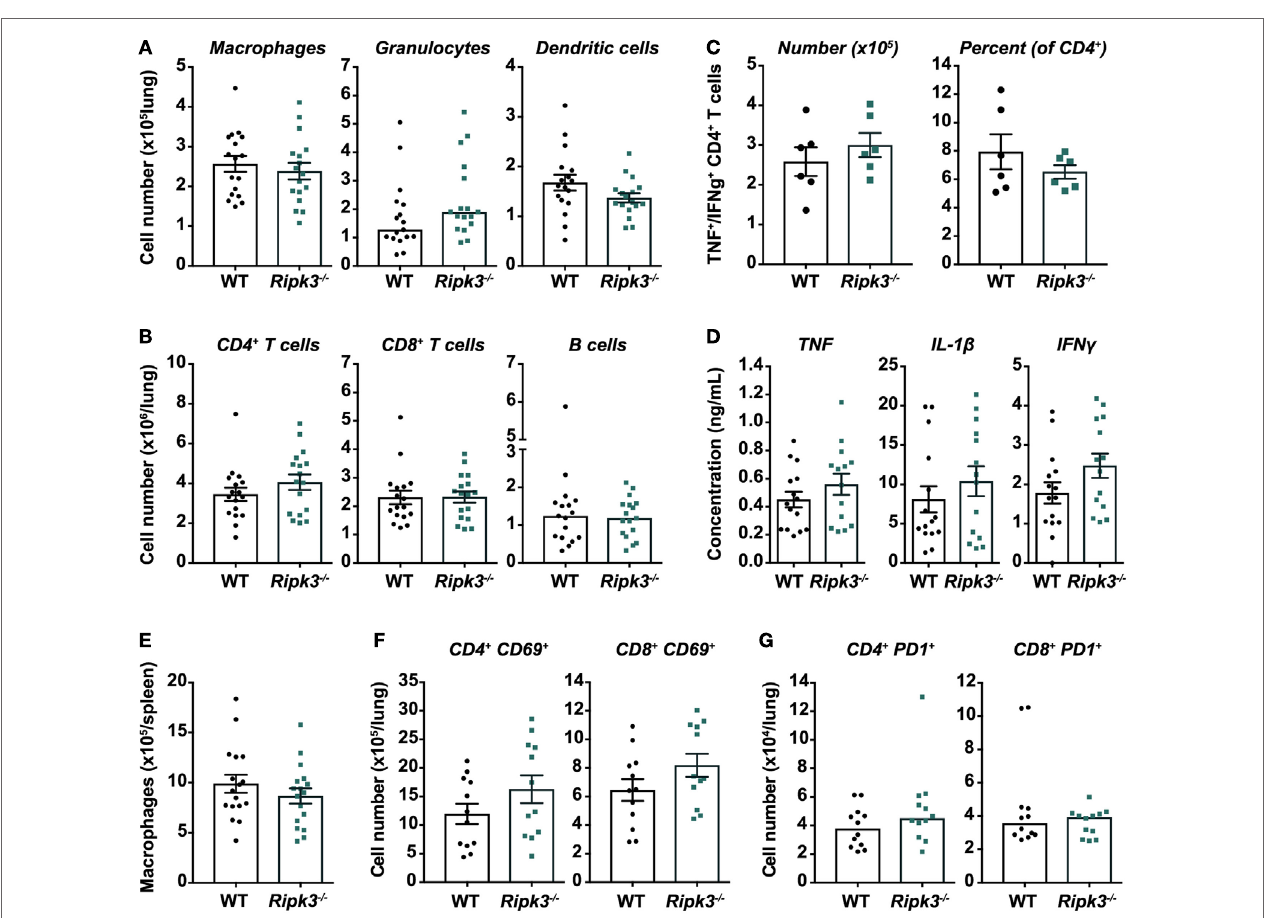
FigUre 4 | Immune responses in Mycobacterium tuberculosis (Mtb)-infected mice are unaltered by receptor-interacting protein kinase 3 deficiency. Total number of (a) myeloid and (B) lymphoid immune cells in the lungs of mice infected with aerosolized Mtb. Flow cytometry was used to identify macrophages/ monocytes (CD11b + Gr1 low ), granulocytes (CD11b + Gr1 high ), dendritic cells (CD11c + MHCII + ), CD4 + and CD8 + T cells, and B cells (CD19 + MHCII + ). Data were pooled from three independent experiments ( n = 17 per genotype). (c) Number of Mtb early secreted antigenic target 6 (ESAT-6)-specific CD4 + T cells in